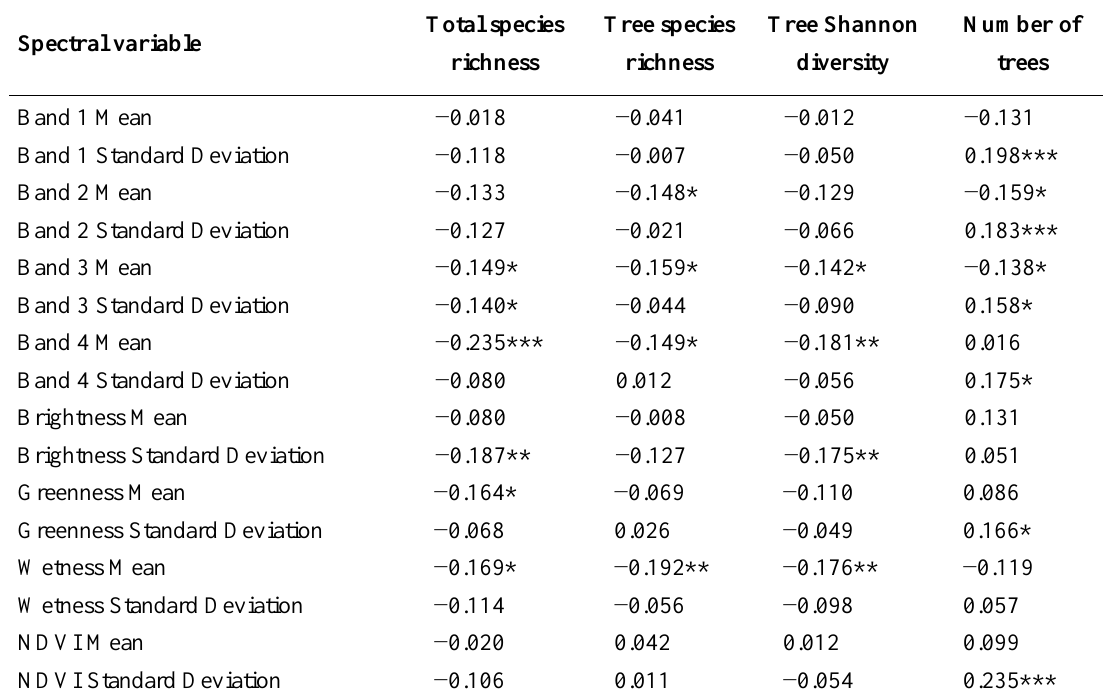
Table 2. Pearson correlation coefficients for species-diversity variables vs. IKONOS